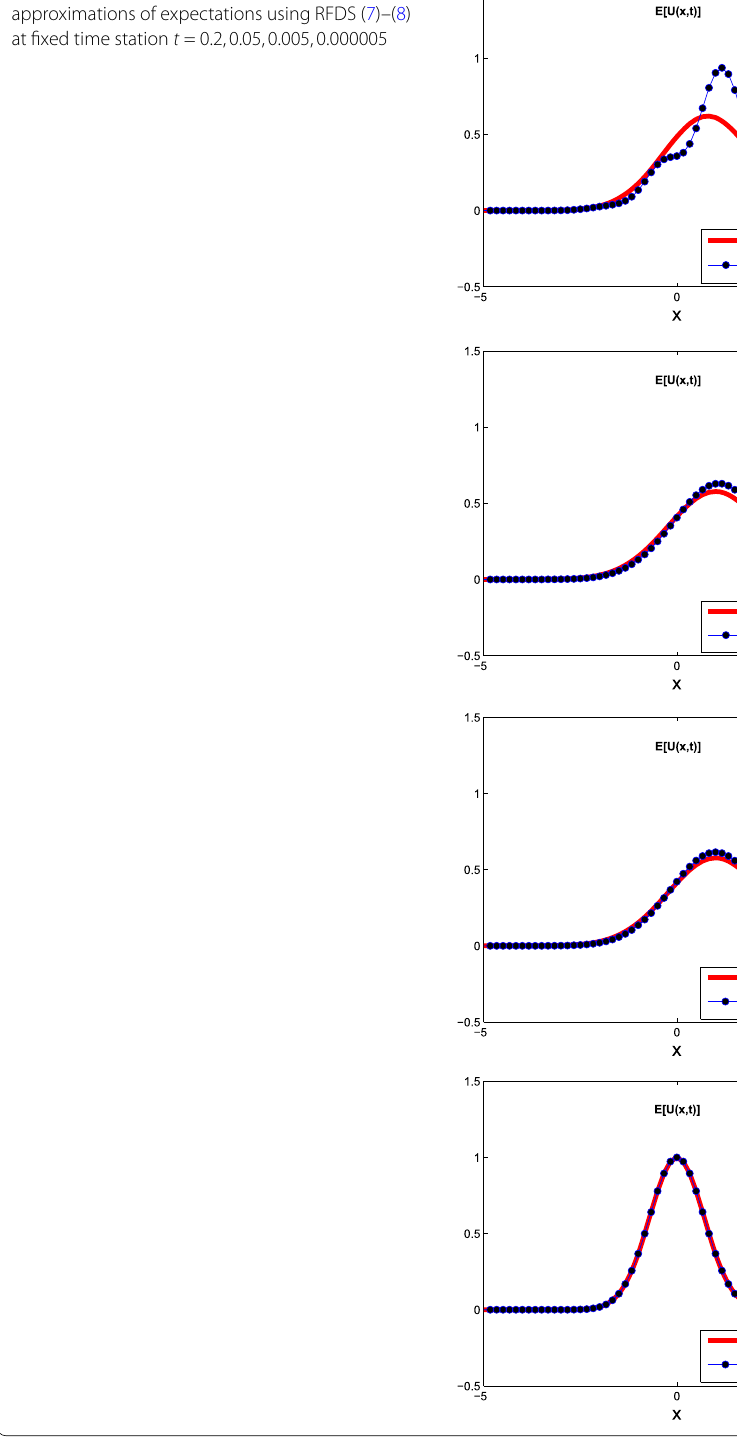
Figure 1 Expectation of the exact solution and the approximations of expectations using RFDS